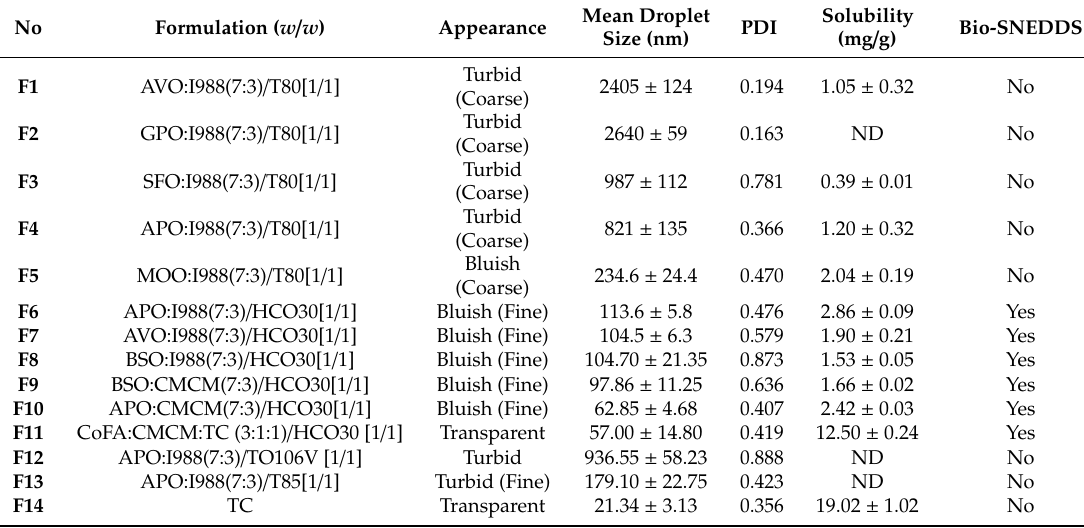
Table 3. Appearance of various formulations and spontaneity upon aqueous dispersion. Additionally, composition of samples, concentration (%) of excipients in anhydrous formulation, droplet size, polydispersity index (PDI) and equilibrium solubility of various formulations of APG. ND denotes “not